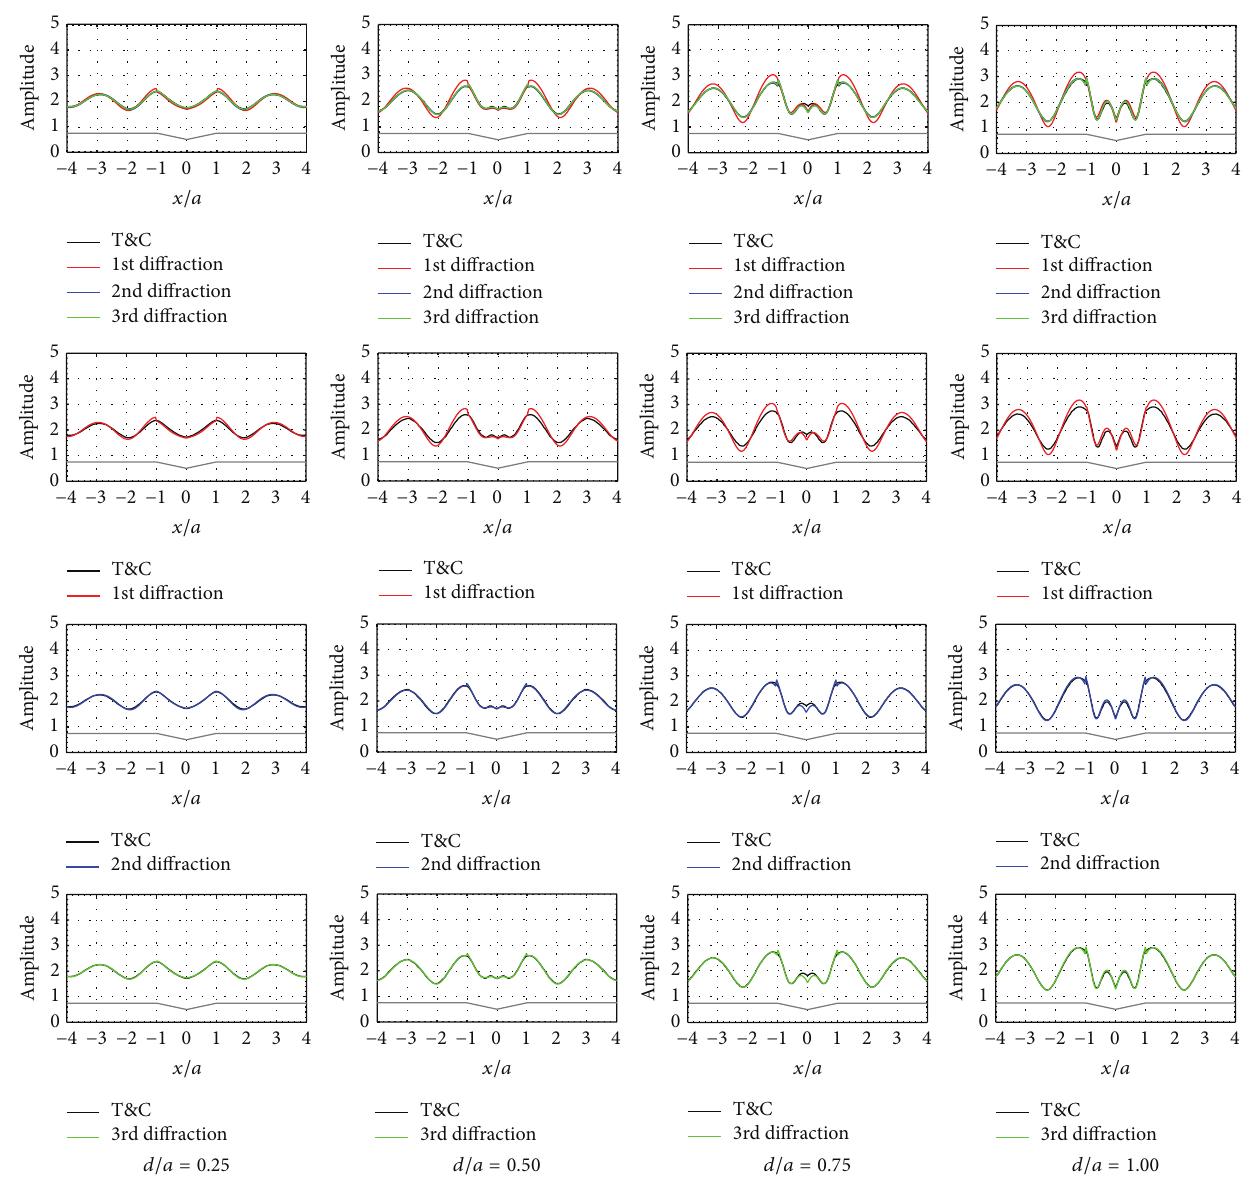
Figure 8: Spatial distribution of the amplitude response function over the free surface of a symmetrical V-shaped canyon with depth-to- width aspect ratio 𝑑/𝑎 = 0.25, 0.50, 0.75, 1.00 and dimensionless frequency 𝜂 = 1.00 . The first row compares the solution for each aspect ratio obtained by the region matching technique reported in Tsaur and Chang [5] (T&C) and the SBD approach (this work) with 1, 2, and 3 orders of